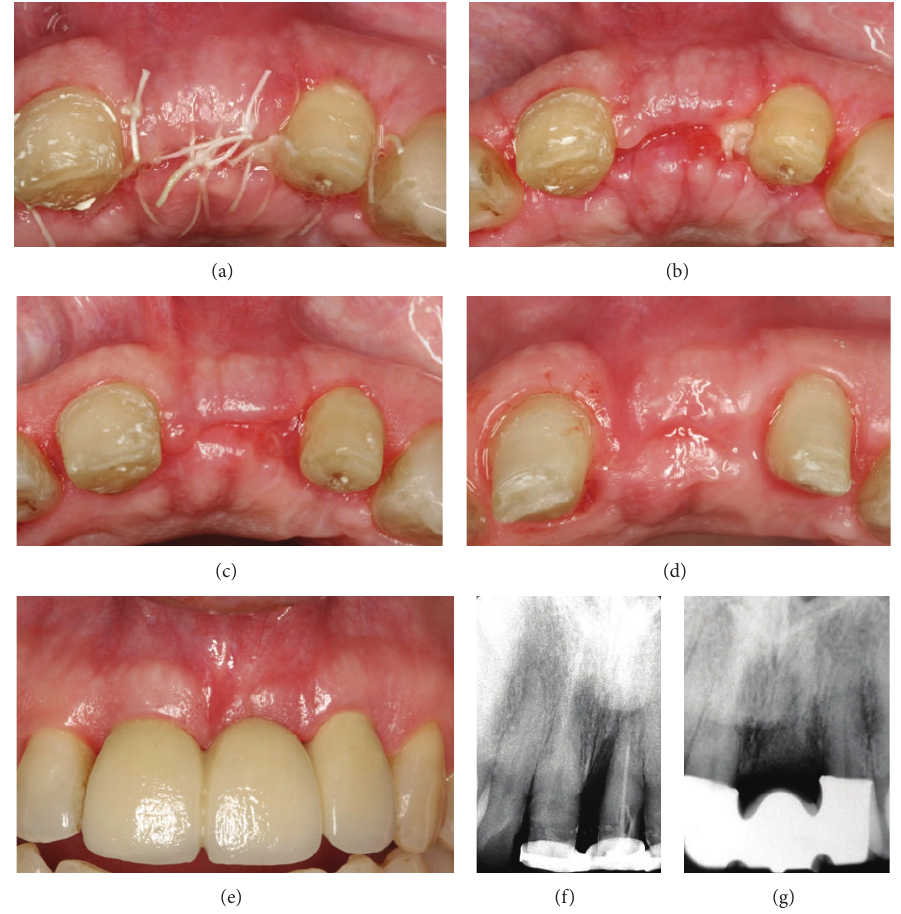
Figure 5: Clinical views of Case 2. Postoperative appearance at (a) 1 week, (b) 2 weeks, (c) 4 weeks, (d) 3 months and (e) 6 months with the definitive prosthesis. Periapical radiographs (f) before extraction and (g) at 6 months